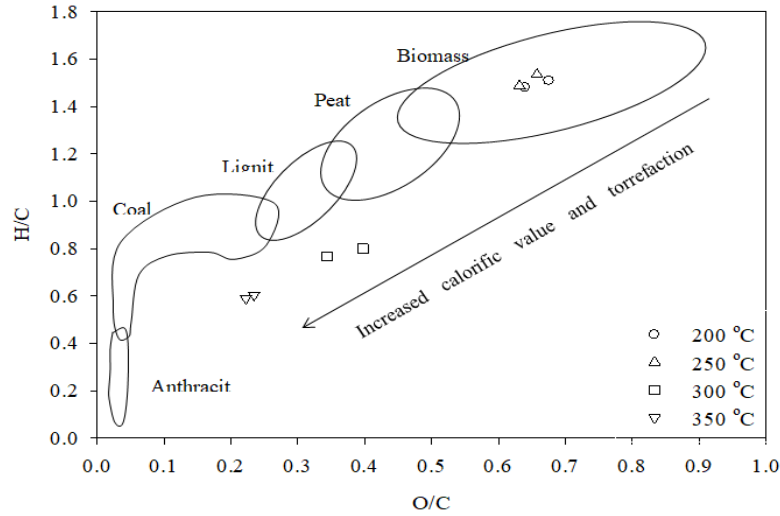
Figure 4. Van Krevelen diagram of waste wood with respect to torrefaction temperature.